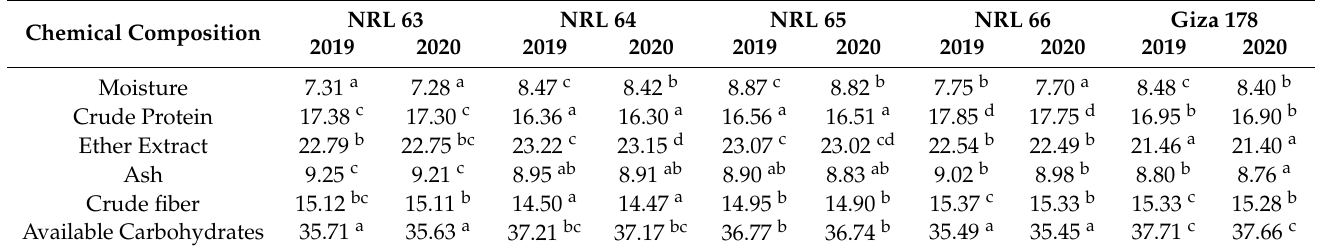
Table 4. Mean performances for gross chemical composition (%) of stabilized rice bran samples of the studied genotypes during the 2019 and 2020 growing